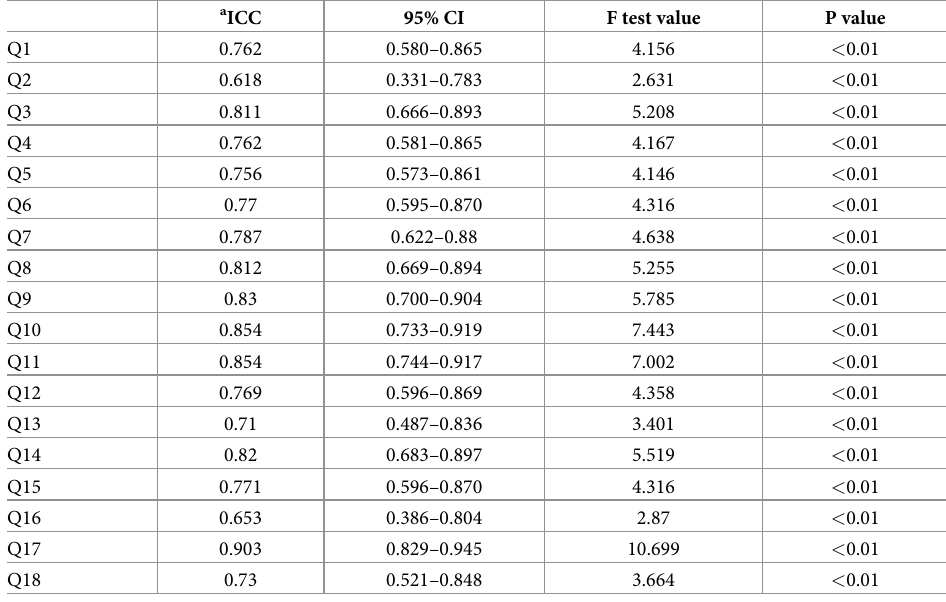
Table 5. Intraclass correlation